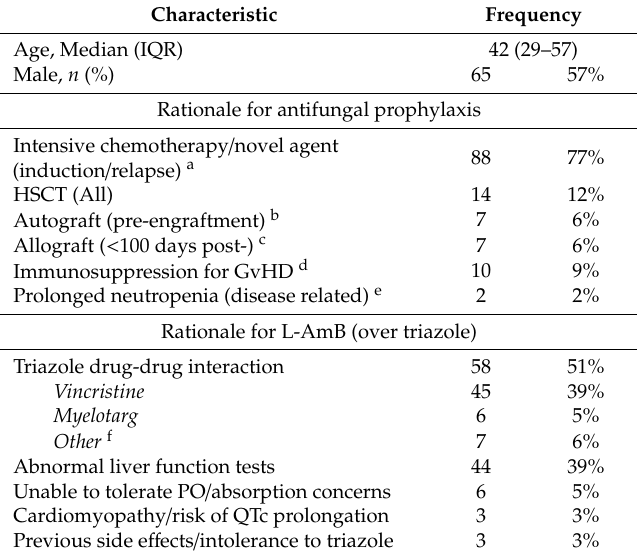
Table 2. Baseline characteristics and rationale for intermittent high-dose L-AmB prophylaxis ( n =